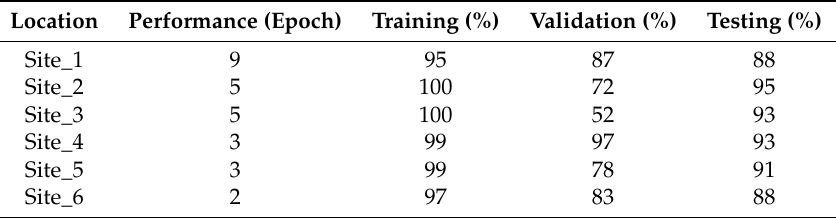
Table 1. ANN model output for all the sites.